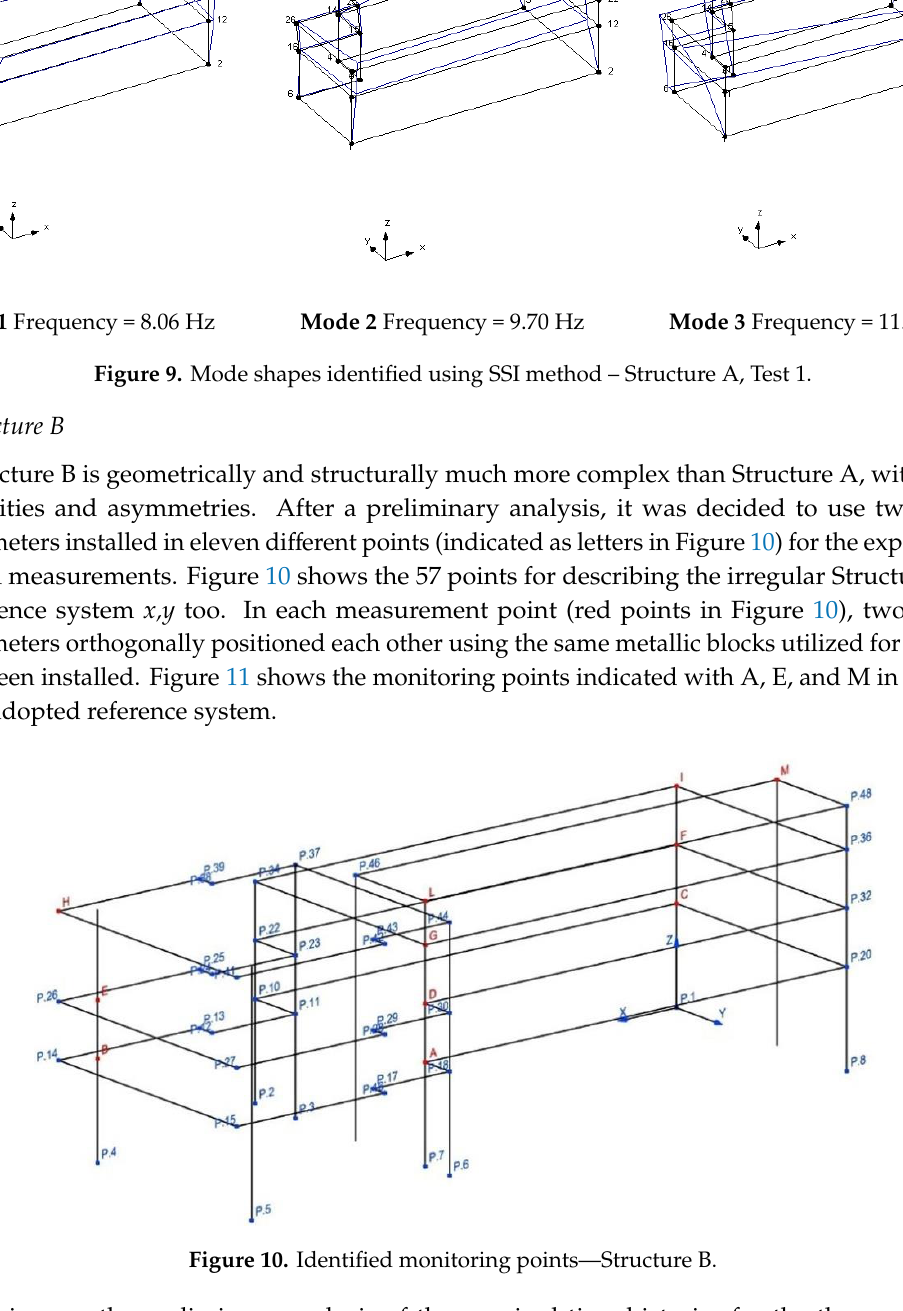
8 of 24 Figure 8. OMA identification with Stochastic Subspace Identification (SSI) method, Test 1. Table 1. Experimental identified frequencies (Hz) by SSI and EFDD techniques and mode shape type. STRUCTURE A.